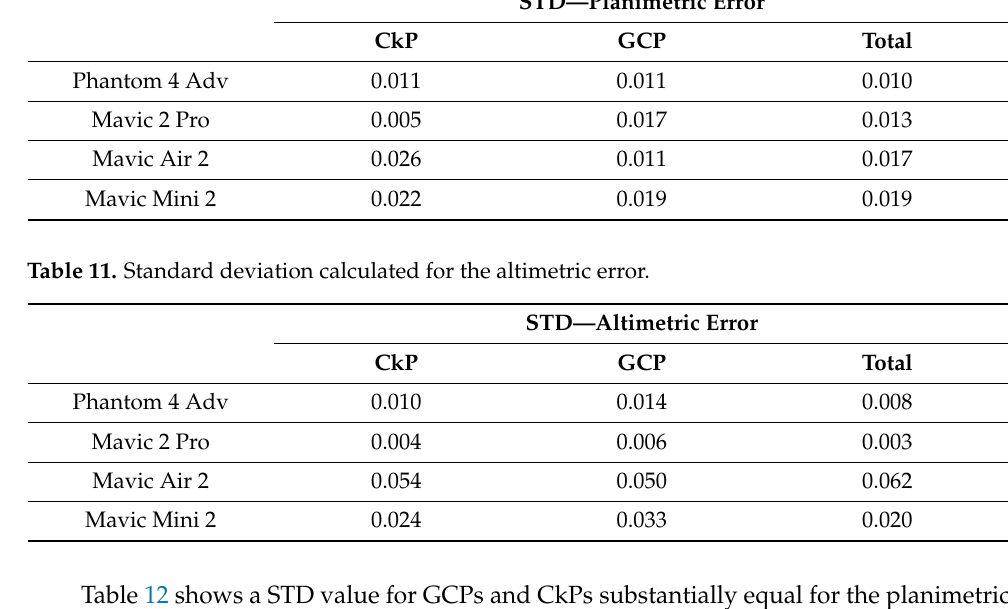
Table 12. Standard deviation calculated on the planimetric and altimetric errors.